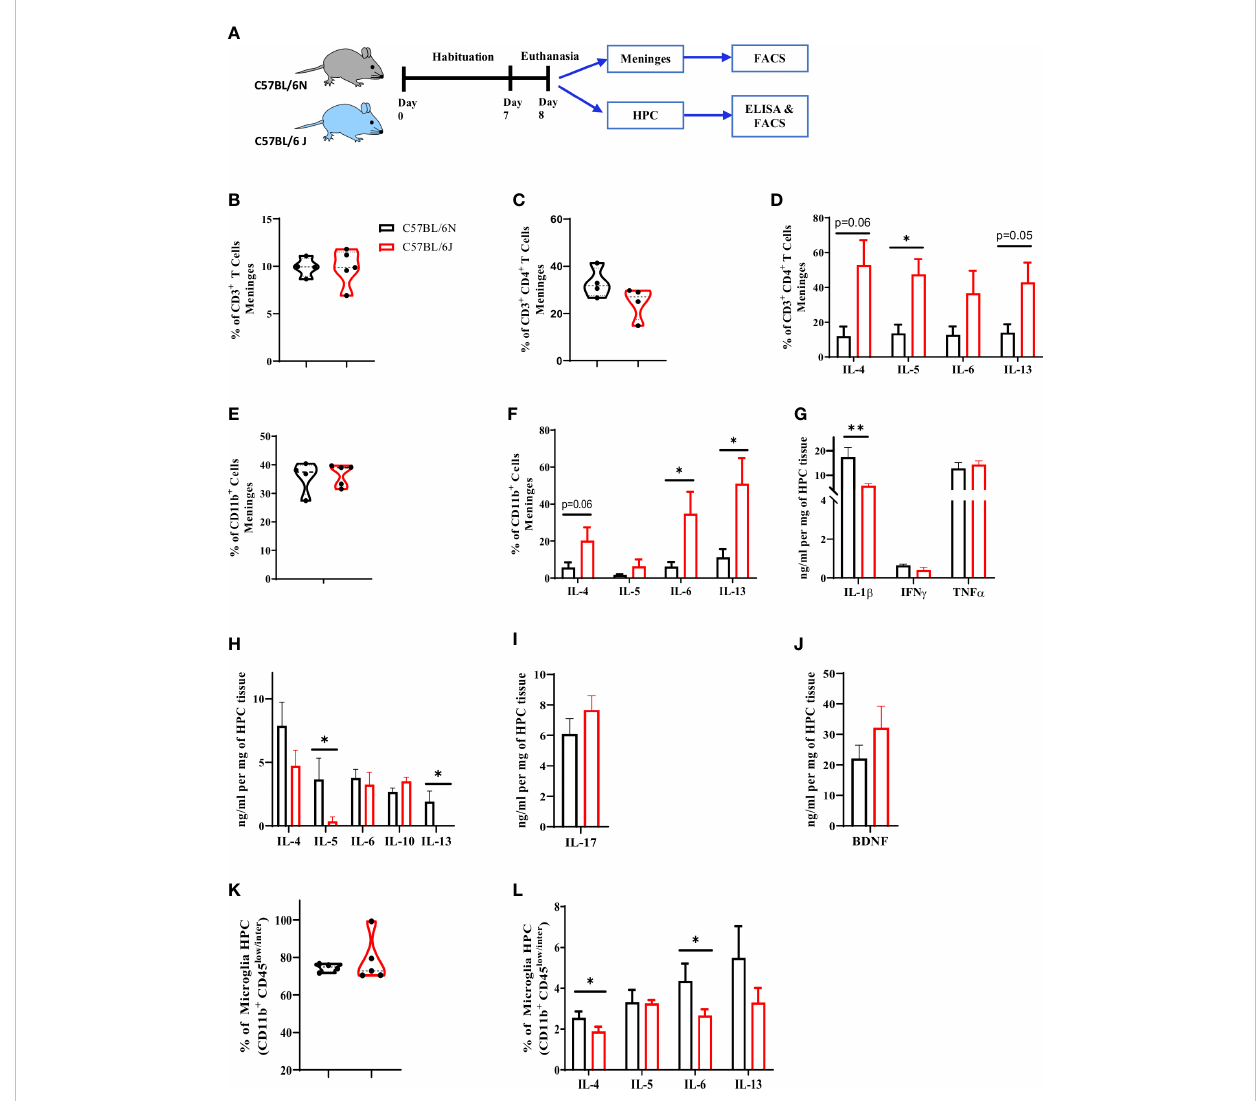
FIGURE 1 Characterization of immune cell pro fi le in meninges and hippocampus in C57BL/6 sub-strains. (A) Experimental design. Meninges and HPC were collected from naïve adult mice and the proportion of immune cells and level of cytokines were assessed using fl ow cytometry and ELISA. (B) Frequency of CD3 + T cells, (C) CD4 + T cells, and (D) IL-4, IL-5, IL-6 and IL-13-expressing CD4 + T cell in meninges. (E) Frequency of CD11b+ cells and (F) IL-6, IL-4, IL-5, and IL-13-expressing CD11b + cell in meninges. The level of (G) Type 1, (H) Type 2, and (I) Type 17 cytokines as well as (J) BDNF using ELISA and normalized to mg of HPC tissue. (K) Frequency of microglia (CD11b + CD45 low/inter ) in HPC. (L) frequency of IL-6, IL-4, IL-5, and IL-13-producing microglia under steady state. Results are representative of three independent experiments with 4 – 7 mice/group. Data are expressed as mean ± S.E.M. * P < 0.05, ** P < 0.001 by two-tailed unpaired Student